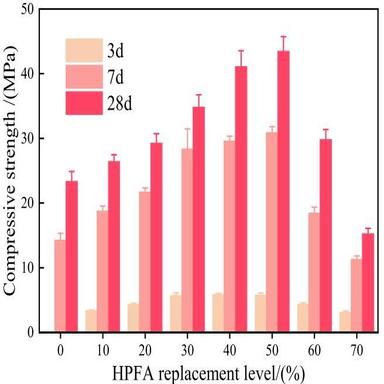
Compressive strength of specimens with different HPFA dosage.